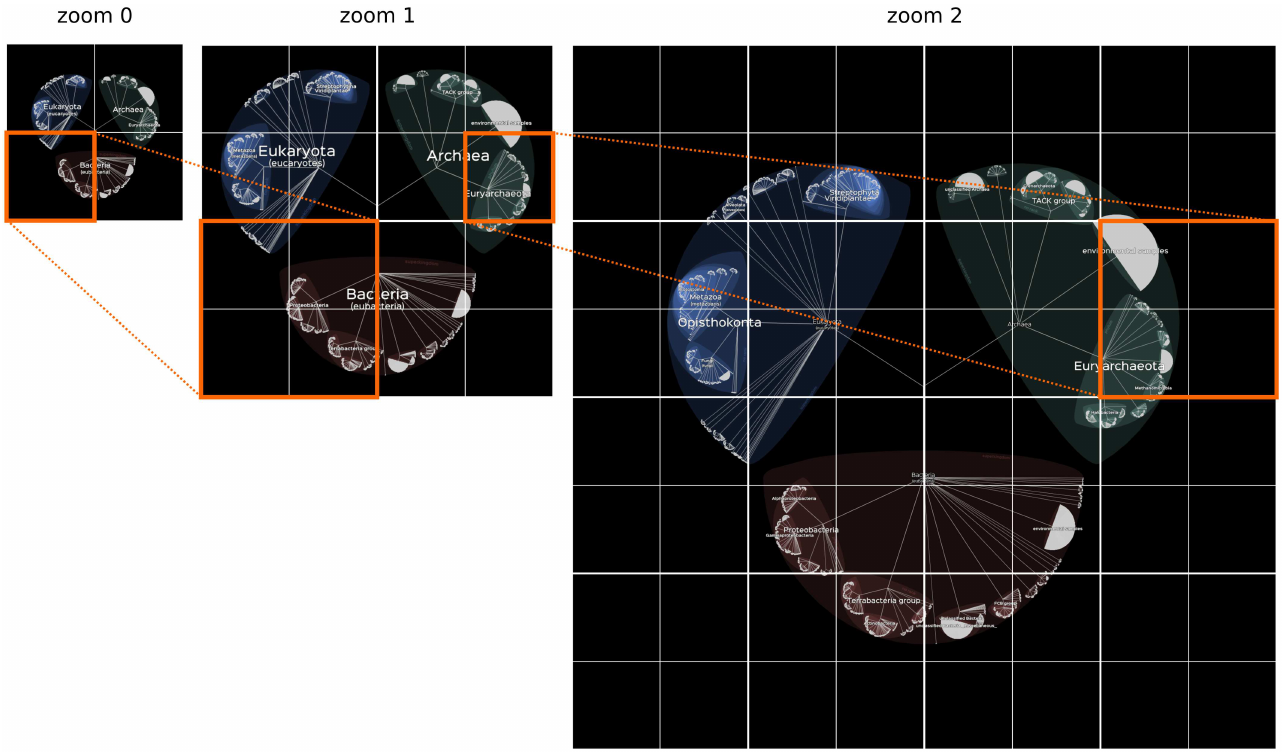
Fig 4. Principle of the tiling systemused in Lifemap. Like in OSM, the image displayedat a given zoom level is composedof paving (or tiling) of small square images. To each of these squareimages at a given zoom level corresponds four images of the same size at the next